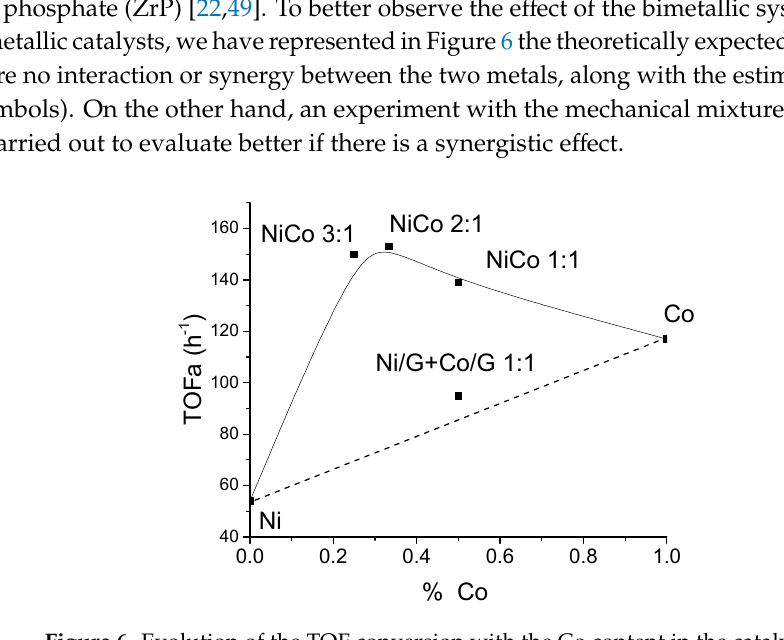
Figure 7. Distribution of the products obtained for each catalyst at 300 °C, 5.0 MPa compared at the same conversion. Figure 7 shows that for the monometallic catalysts, the distribution obtained was quite different. Phenol and cyclohexanol were the primary product on Ni catalyst, and according to the evolution of the product selectivity with the conversion (Figure 8), the formation of cyclohexanol was obtained from phenol hydrogenation. On the other hand, for Co catalyst phenol was the main product obtained, and based on the evolution of phenol selectivity with conversion, the further hydrogenation to cyclohexanol was inhibited, indicating that Co was less active for hydrogenation than Ni. Those observations are in agreement with the results reported for phenol conversion over Co/HZSM-5 catalyst, where it was observed that phenol conversion was much lower than Ni/HZSM-5 [34]. Nevertheless, in the case of the Ni/HZSM-5, the main product obtained was cyclohexane, while in our case, cyclohexanol was the final product; such difference could be ascribed to the difference in the acidity of the support [18,34,41]. In fact, in the case of bimetallic NiCo-based catalyst, different supports were compared in the conversion of phenol, and the product distribution was able to be